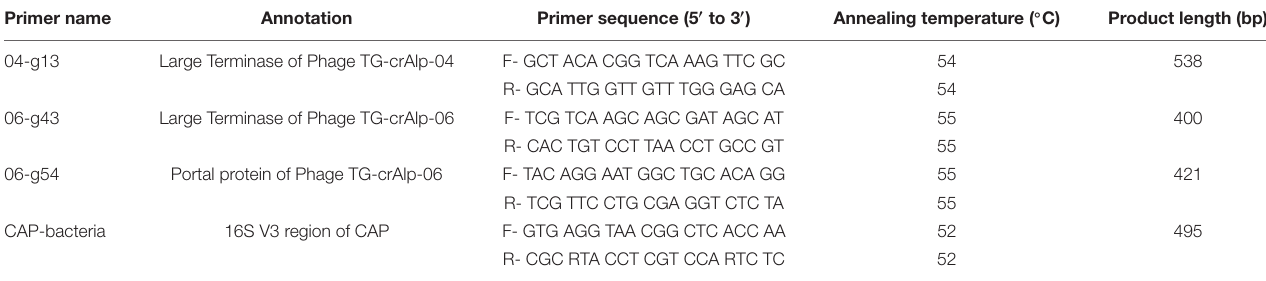
TABLE 1 | Primer pairs designed for phage signature genes and 16S rRNA gene region of host bacteria Candidatus Azobacteroides pseudotrichonymphae